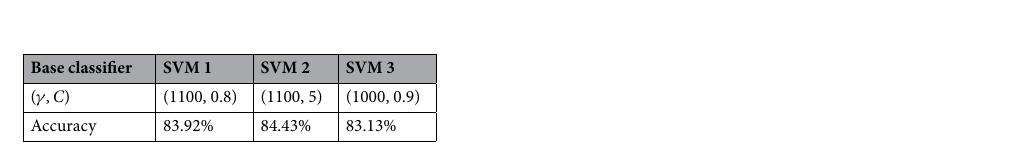
Table 1. The parameter optimization results of the base classifier and